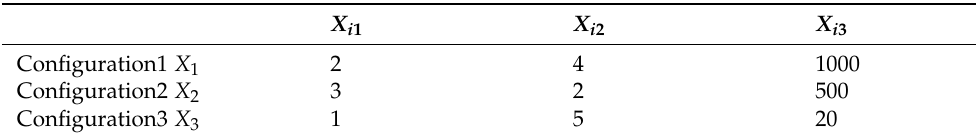
Figure 1. General Framework of OCATC. Table 2. Representation of the